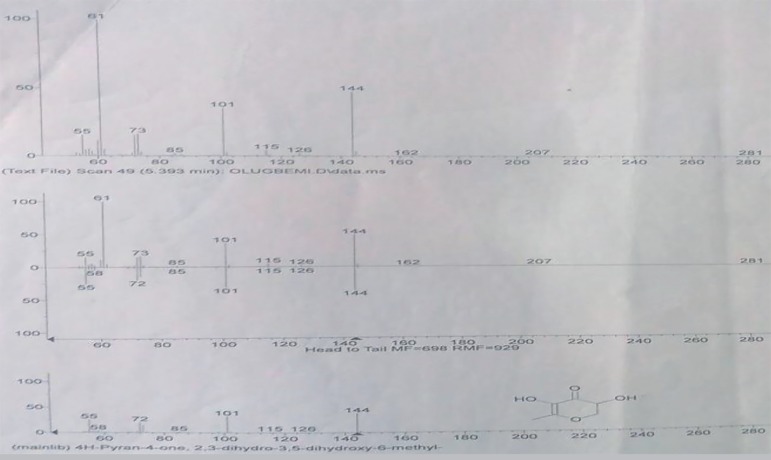
Structure of the major flavonoid fraction 4H-Pyran-4-One
2,3-Dihydro-3,5-Dihydroxy-6-Methyl in GC-MS analysis